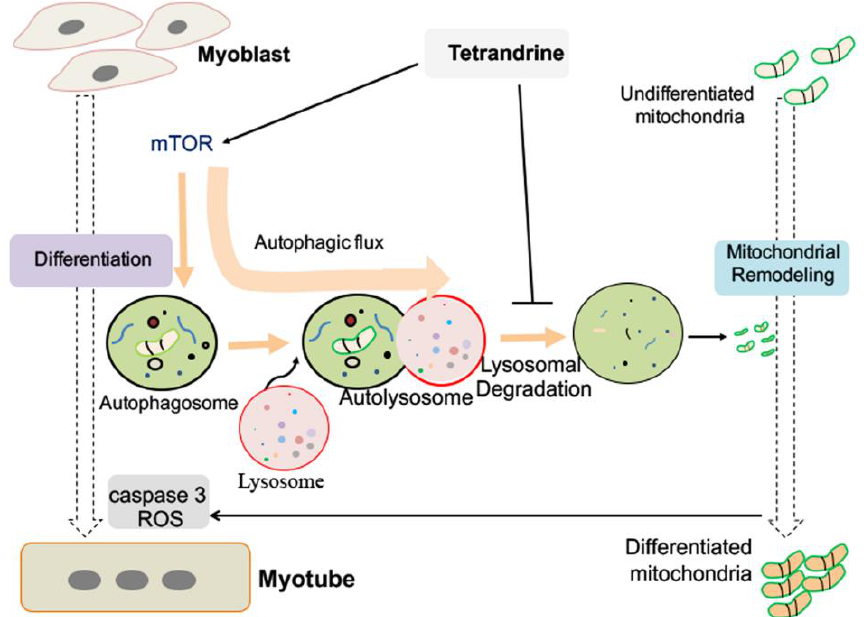
Figure 6. A working model for tetrandrine in myogenic differentiation of myoblasts. Tetrandrine activates the early stage and blocks the late stage of autophagic flux during the differentiation progression of myoblasts. The blockade of autophagic flux contributes to mitochondrial remodeling, which leads to a decrease in ROS production and caspase 3 activation, and thereby the inhibition of myogenic differentiation.